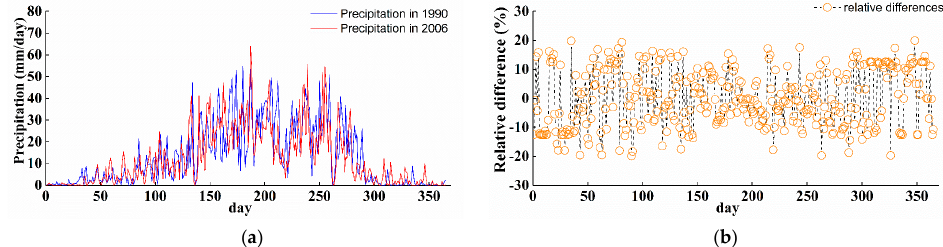
Figure 5. The line chart of ( a ) precipitation variations in 1990 (blue lines) and those variations in 2006 (red lines); and ( b ) the relative differences of precipitation in 1990 and 2006.